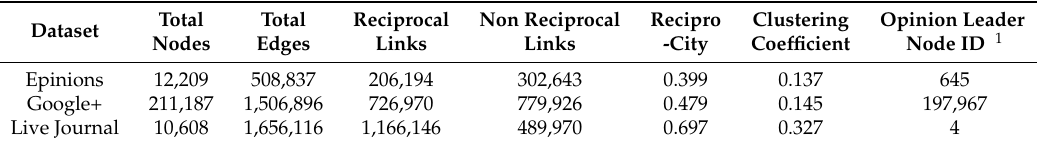
Table 2. Characteristics of the social networks used in the empirical